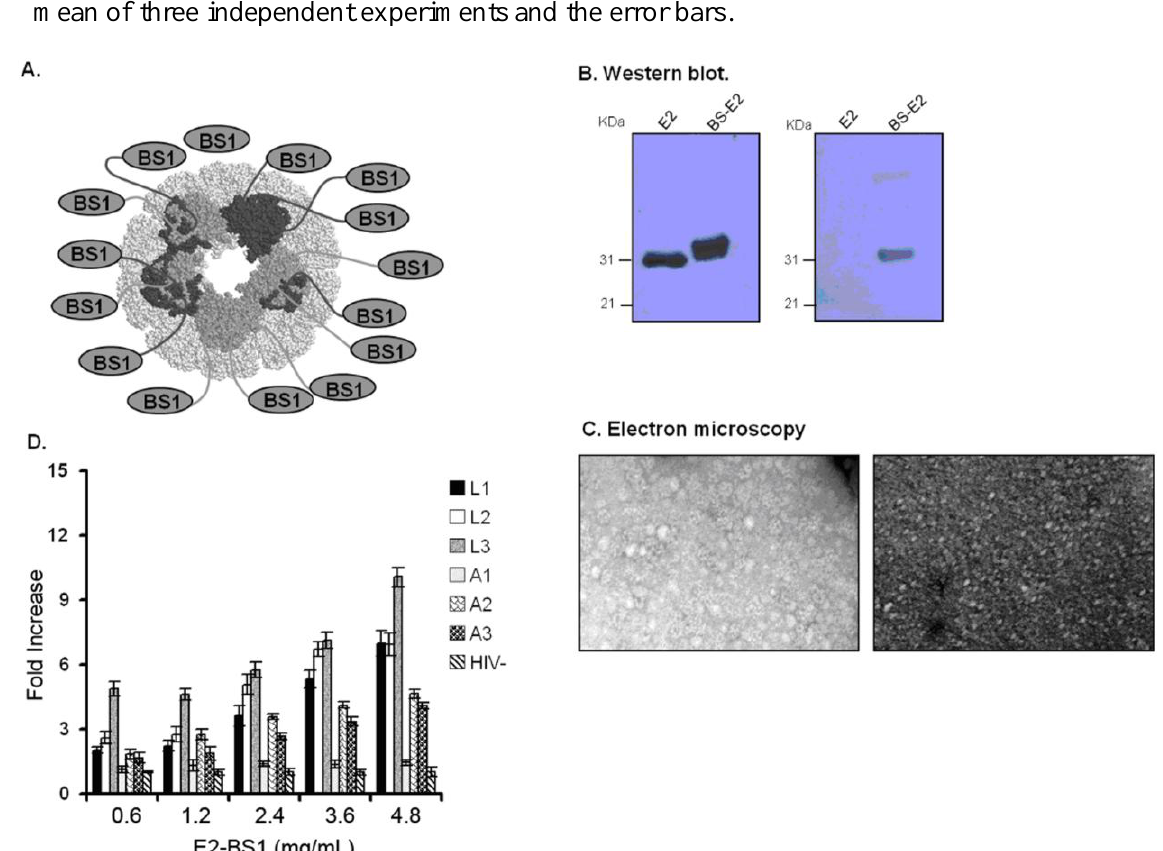
Figure 3. Antigenicity of E2-BS1. ( A ) Schematic representation of G. stearothermophylus E2 protein. E2 protein (di-hydro-lypoil-acetyl-transferase) is the central scaffold of the PDH complex. The peptide is directly bound to the core domain of E2 multi-subunit complex without altering the E2 structure. The complex includes about 20 trimeric subunits and each subunit display the BS1 mimotope. ( B ) Western blot analysis to detect E2-BS1 expression. Immunoblot of E2 wt and E2-BS1 recombinant using anti-E2 polyclonal sera (left panel) or anti mouse serum containing antibodies against BS mimotope, obtained from mice immunized by E2-BS1 (right panel). ( C ) Electron microscopy of E2-BS1 complex. Electron micrographs of E2 wild type (left panel) and E2-BS1 recombinant (right panel) stained with uranyl acetate solution. (magnification 160,000×). ( D ) Antigenicity was assessed by performing a direct ELISA assay with increasing concentrations of E2-BS1 protein. IgGs purified from LTNPs sera (marked as L1–L3) and conclamate AIDS sera (marked as A1–A3) were assessed. IgGs purified from a HIV donor serum were used as a control. Results are reported as HIV + sera/HIV serum ratio (fold increase) and a fold increase ≥3 was considered as positive result. The graph reports the mean of three independent experiments and the error